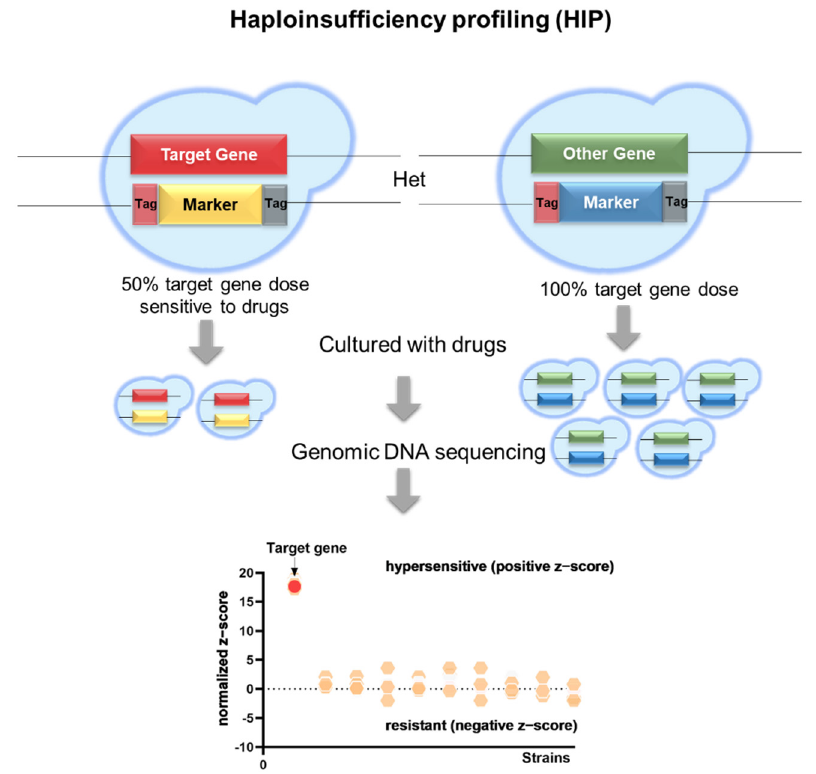
Figure 2. Schematic description of haploinsufficiency profiling (HIP). Heterozygous deletion mutants in a diploid were constructed by homologous recombination. Each strain was tagged with two unique DNA barcodes. The heterozygous mutant libraries were treated with antifungal drugs for dozens of doubling times. Then, genomic DNA were isolated, and the DNA barcodes were amplified by PCR. Finally, the barcodes were sequenced and normalized to the untreated pool. Het, heterozygous.